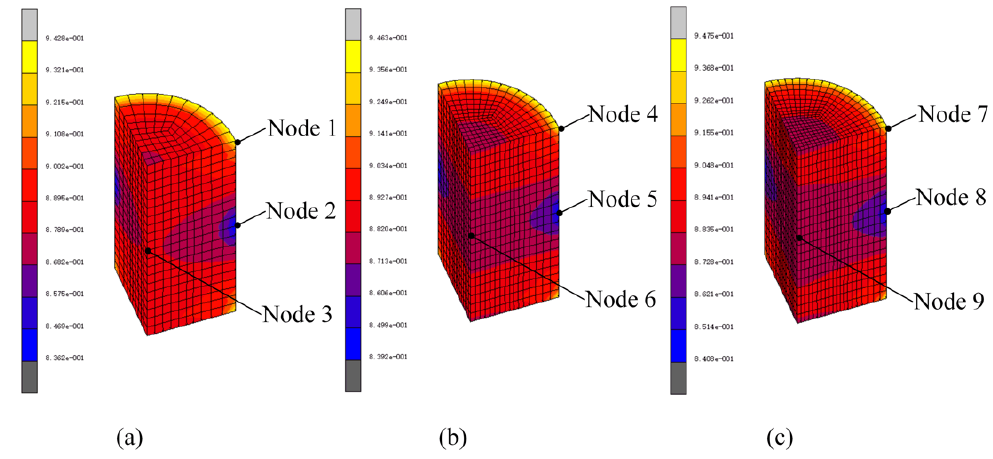
Figure 4. Comparison of relative density distributions for different mesh sizes. ( a ) sparse mesh, ( b ) general mesh, ( c ) dense mesh.